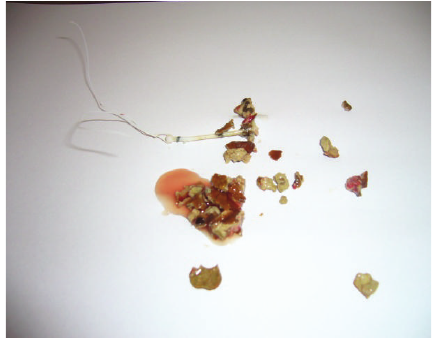
Figure 4: IUD and stone fragments after